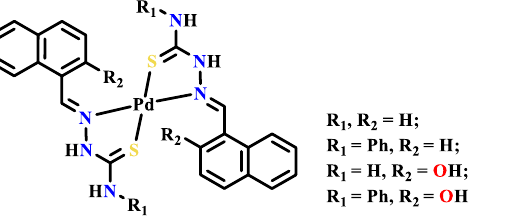
Figure 29. A series of palladium(II) complexes of naphthylhydrazone with N -substituted thiourea side chain.